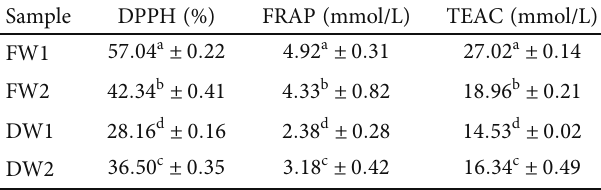
Table 3: Antioxidant properties of wine samples.